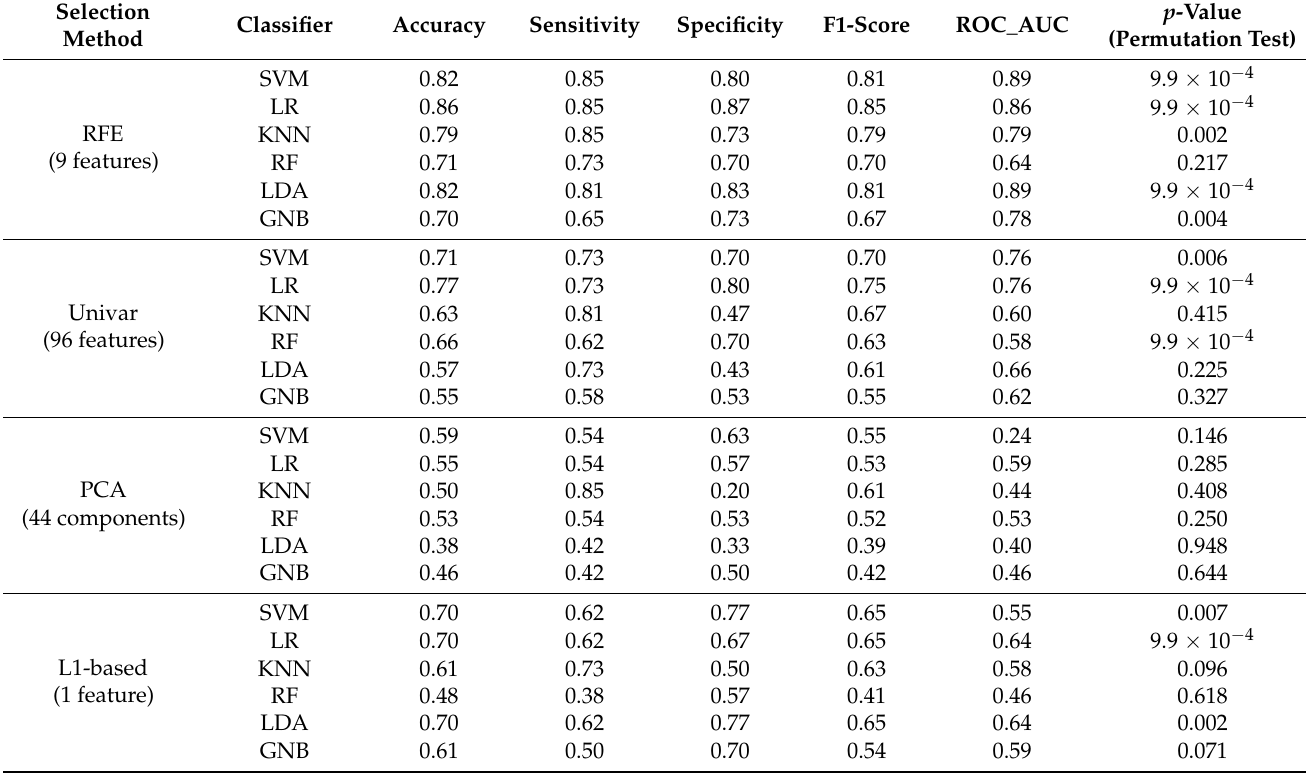
Table 3. Comparing performance among different combinations of four feature selection methods and six classifiers in structural